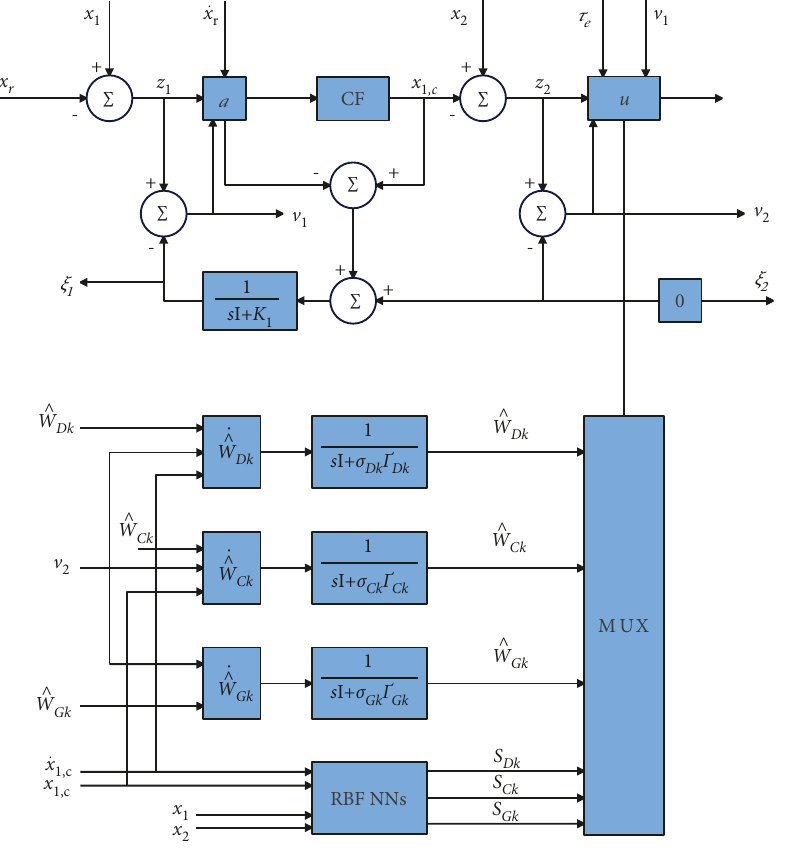
Figure 1: . Flowchart of the controller